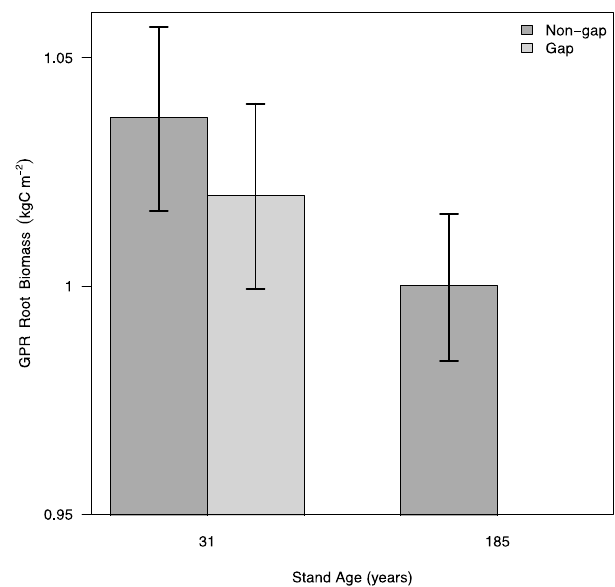
Figure 5. Influence of canopy gaps and stand age on root biomass. Fine-scale mean ( ± 95% confidence intervals) GPR-derived root biomass changes with stand age and disturbance as measured by 2 m GPR transects in subplots located under gaps or continuous canopies. No gaps were present in the 185-year-old stand.